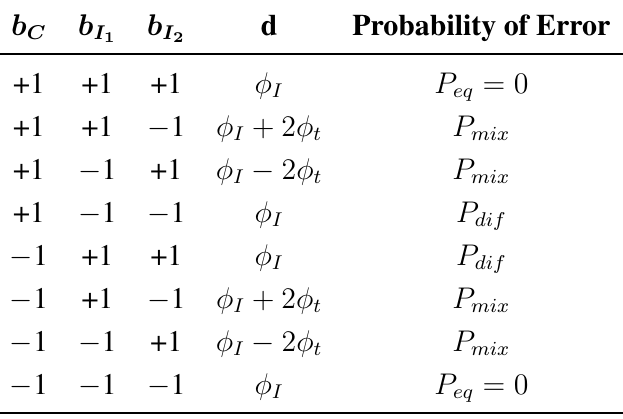
Table 2. Useful and Interferer Chip Phase